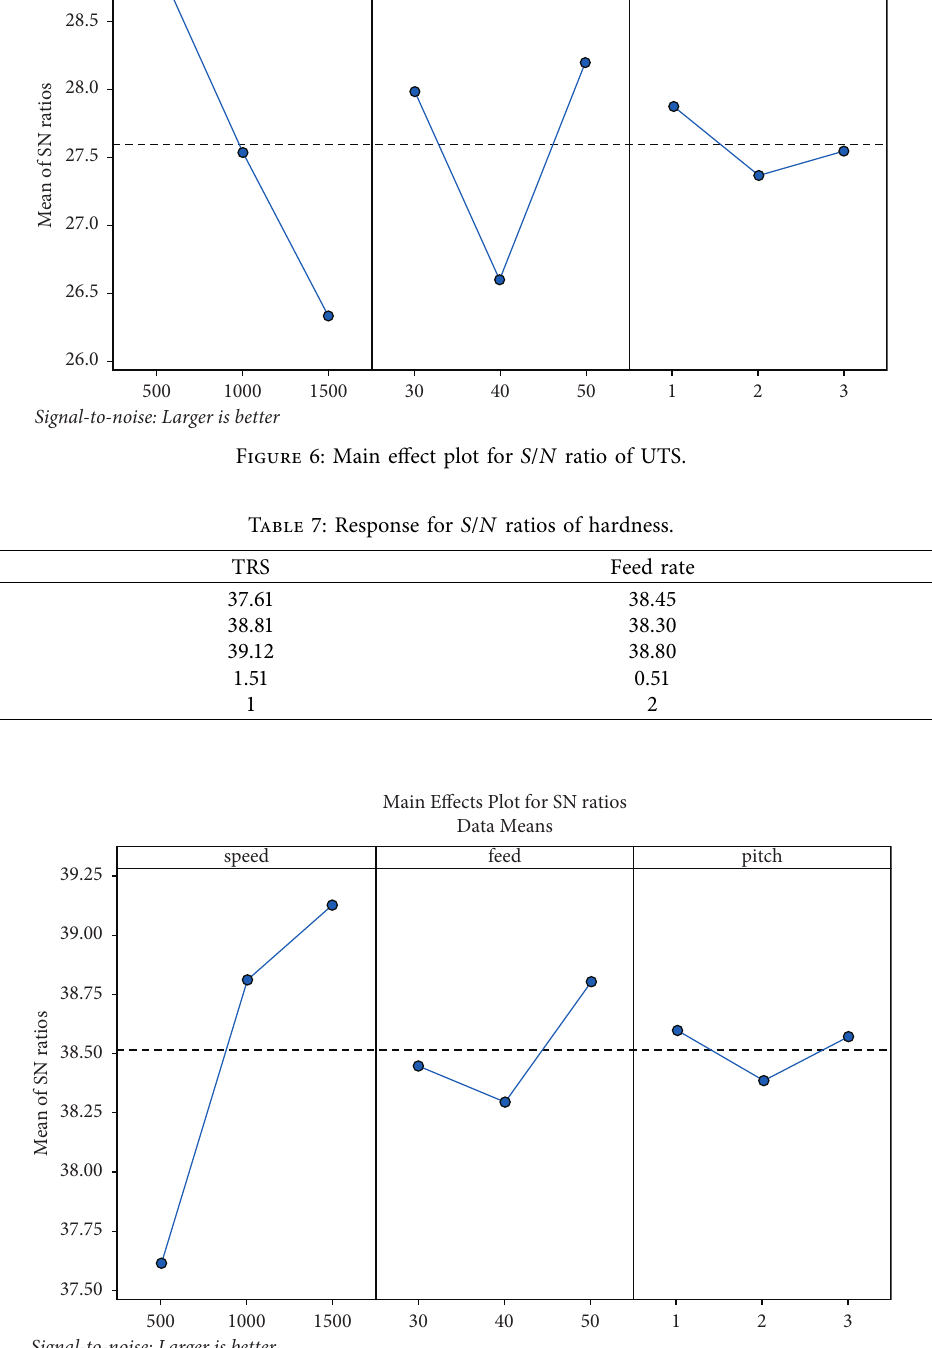
Figure 7: Main effect plot for S / N ratio of